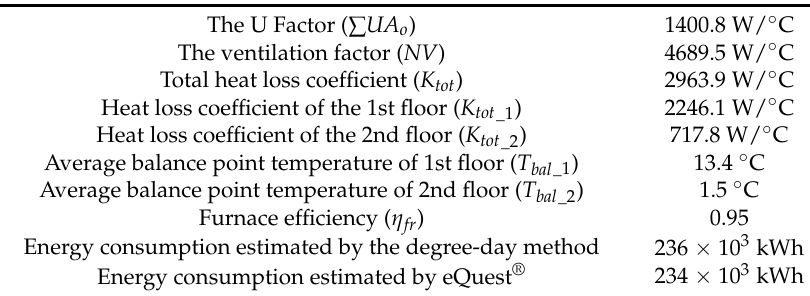
Table 3. Results of the degree-day method.